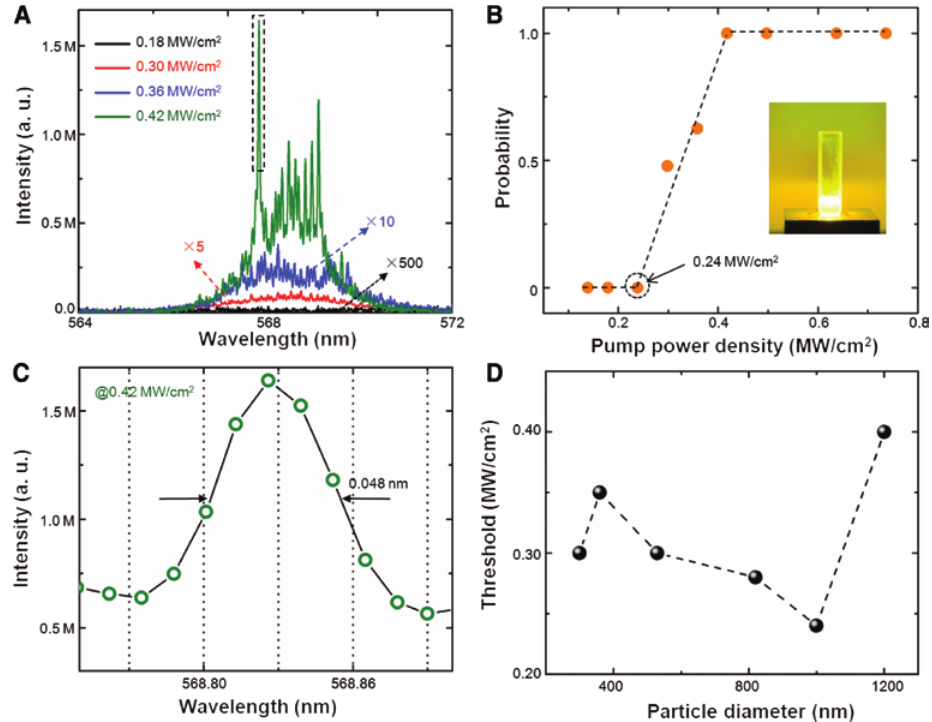
Figure 5: Emission performance of Ag NF-based random laser with R6G. (A) Emission spectra of Ag NF-based random laser with R6G (RL-R6G) pumped by 532 nm pulses under different pump power densities. (B) Probability of random lasing vs. different pump power densities. The inset is the photograph of the RL-R6G. (C) Magnifying emission spectra of RL-R6G pumped at 0.42 MW cm −2 . (D) Threshold of the system vs. the particle diameter of the